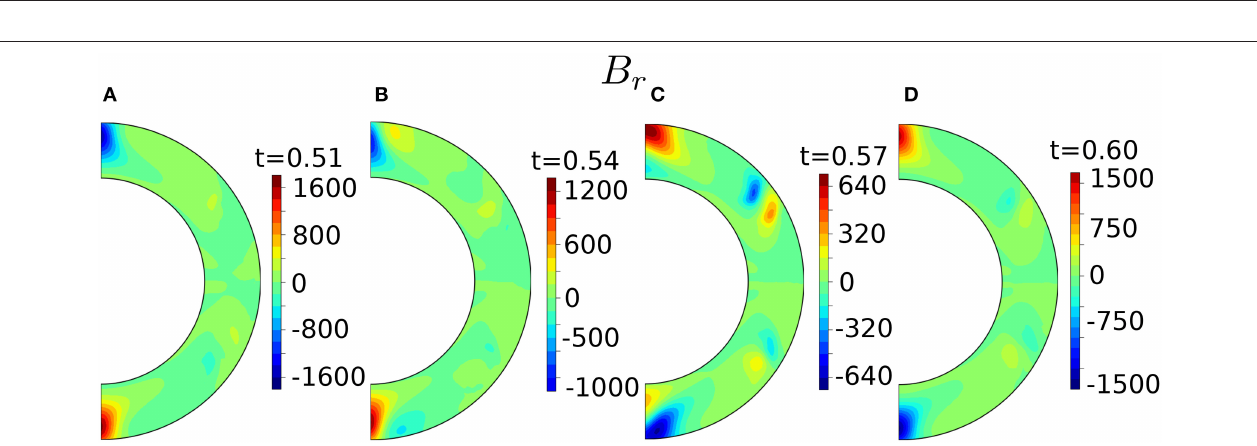
FIGURE 4 | Snapshots of the longitudinally averaged non-dimensional radial magnetic field ( B r ) at different stages during half a solar magnetic cycle. Subfigures show the polarity reversals of the polar field. Here, a unit magnetic field corresponds to 20 Gauss.